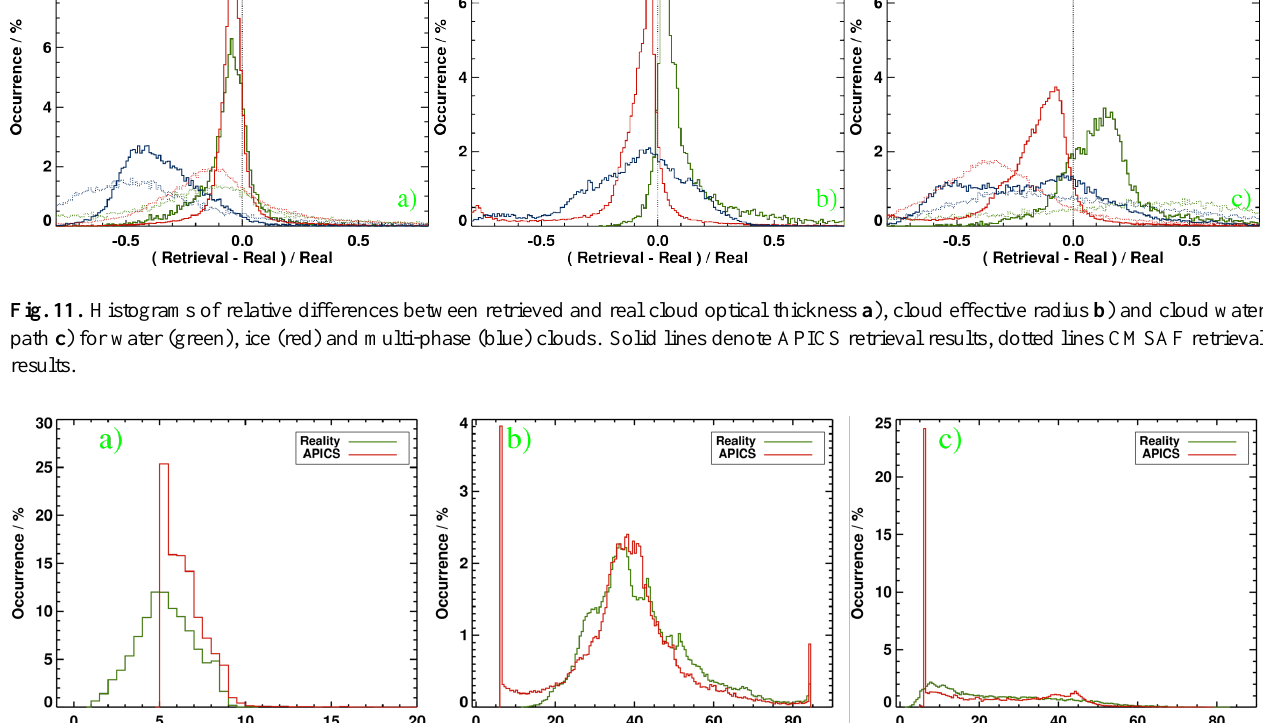
and a retrieval gives optical thickness and effective radius of a ho- mogeneous cloud having (nearly) the same spectral reflectances as the measured one. Thus, effective radius does not only depend on the absorbing intensity of the channel used (Platnick, 2000) but is also highly retrieval dependent and there is no real truth to compare with. Nevertheless, one can think of the retrieved effective radius as a weighted mean of the effective radius vertical profile: Z z bottom r eff , retrieved = r eff (z)w(z)dz, z top where z top and z bottom are the cloud top and bottom height, r eff (z) is the vertical profile of effective radii and w(z) is the vertical weight- ing function. According to Platnick (2000), the weighting func- tion w(z) can be thought of as the fraction of scattering events at a given level of the cloud. We tried to mimick the weighting func- tions presented in Platnick (2000) by considering the scaled optical thickness τ s (i) of the layer i =1,..., nl ( nl =number of cloud layers) and the accumulated scaled cloud optical thickness τ acc , s (j) at level j = 0 ,...,nl +